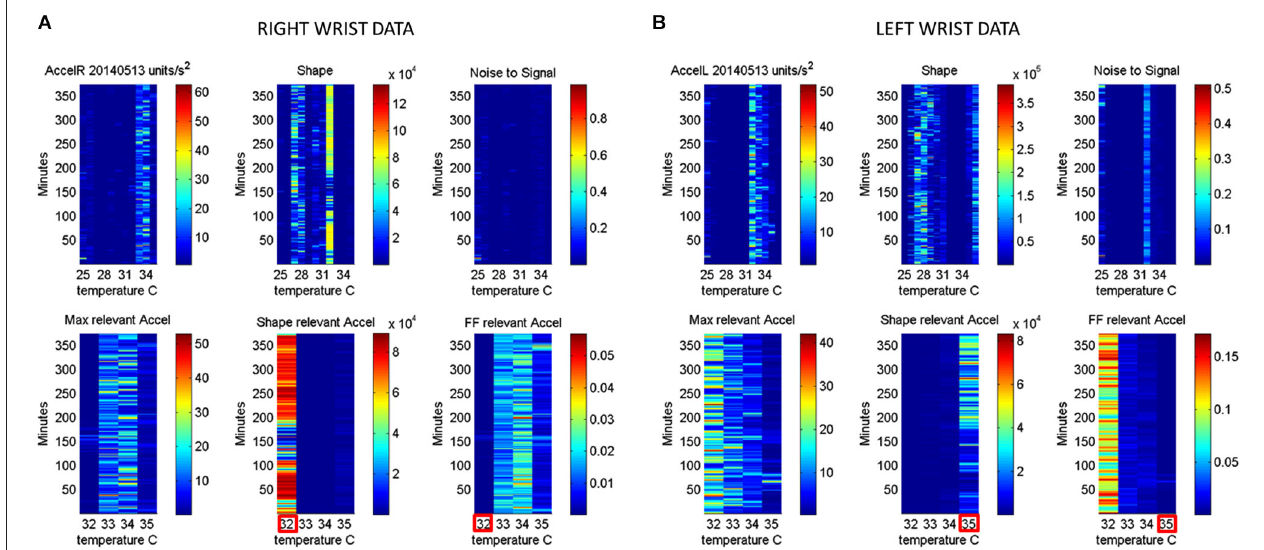
explained in Figure 3 , has the Fano Factor, the noise-to-signal ratio from the estimated Gamma mean and variance parameters for the i th minute and the j th ◦ C. The lower panel contains the subset from the full range of surface skin temperature registered where the noise to signal is lower (minimal level enclosed by red square). In A (the right wrist) minimal noise in the acceleration is at 32 ◦ C (also the highest shape value, indicating most symmetric distribution of the motion parameter). In (B) (the left wrist) the noise-to-signal is low for 32--35 ◦ C, with 35 ◦ C having the lowest noise-to-signal regimes and the most systematic motions indicated by the higher values of the shape